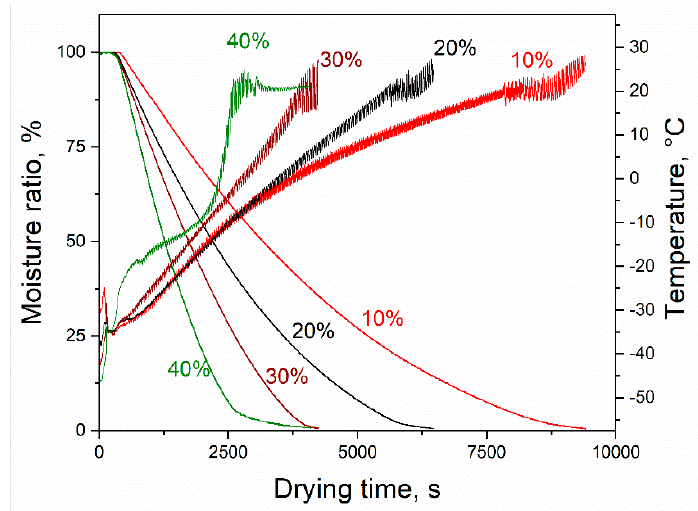
Figure 4. Relative moisture ratio (decreasing curves) and temperature (increasing curves) during microwave-supported freeze-drying of polysorbate 80 foam with different maltodextrin contents.